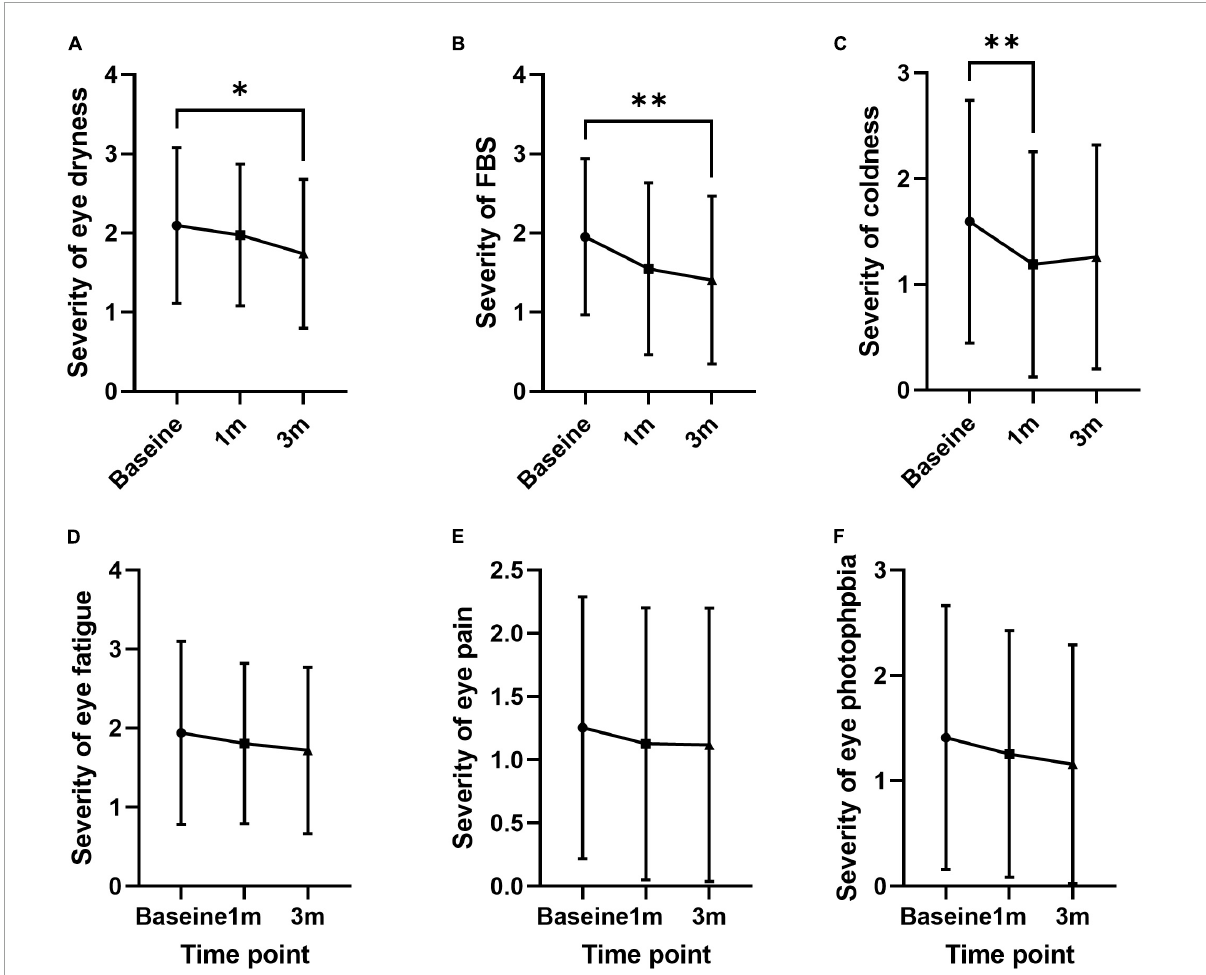
FIGURE4 The effect of MVG on the severity of each dry eye symptom. (A) Dryness. (B) Foreign body sensation. (C) Coldness. (D) Eye fatigue. (E) Pain. (F) Photophobia. ∗ < 0.05 and ∗∗ <